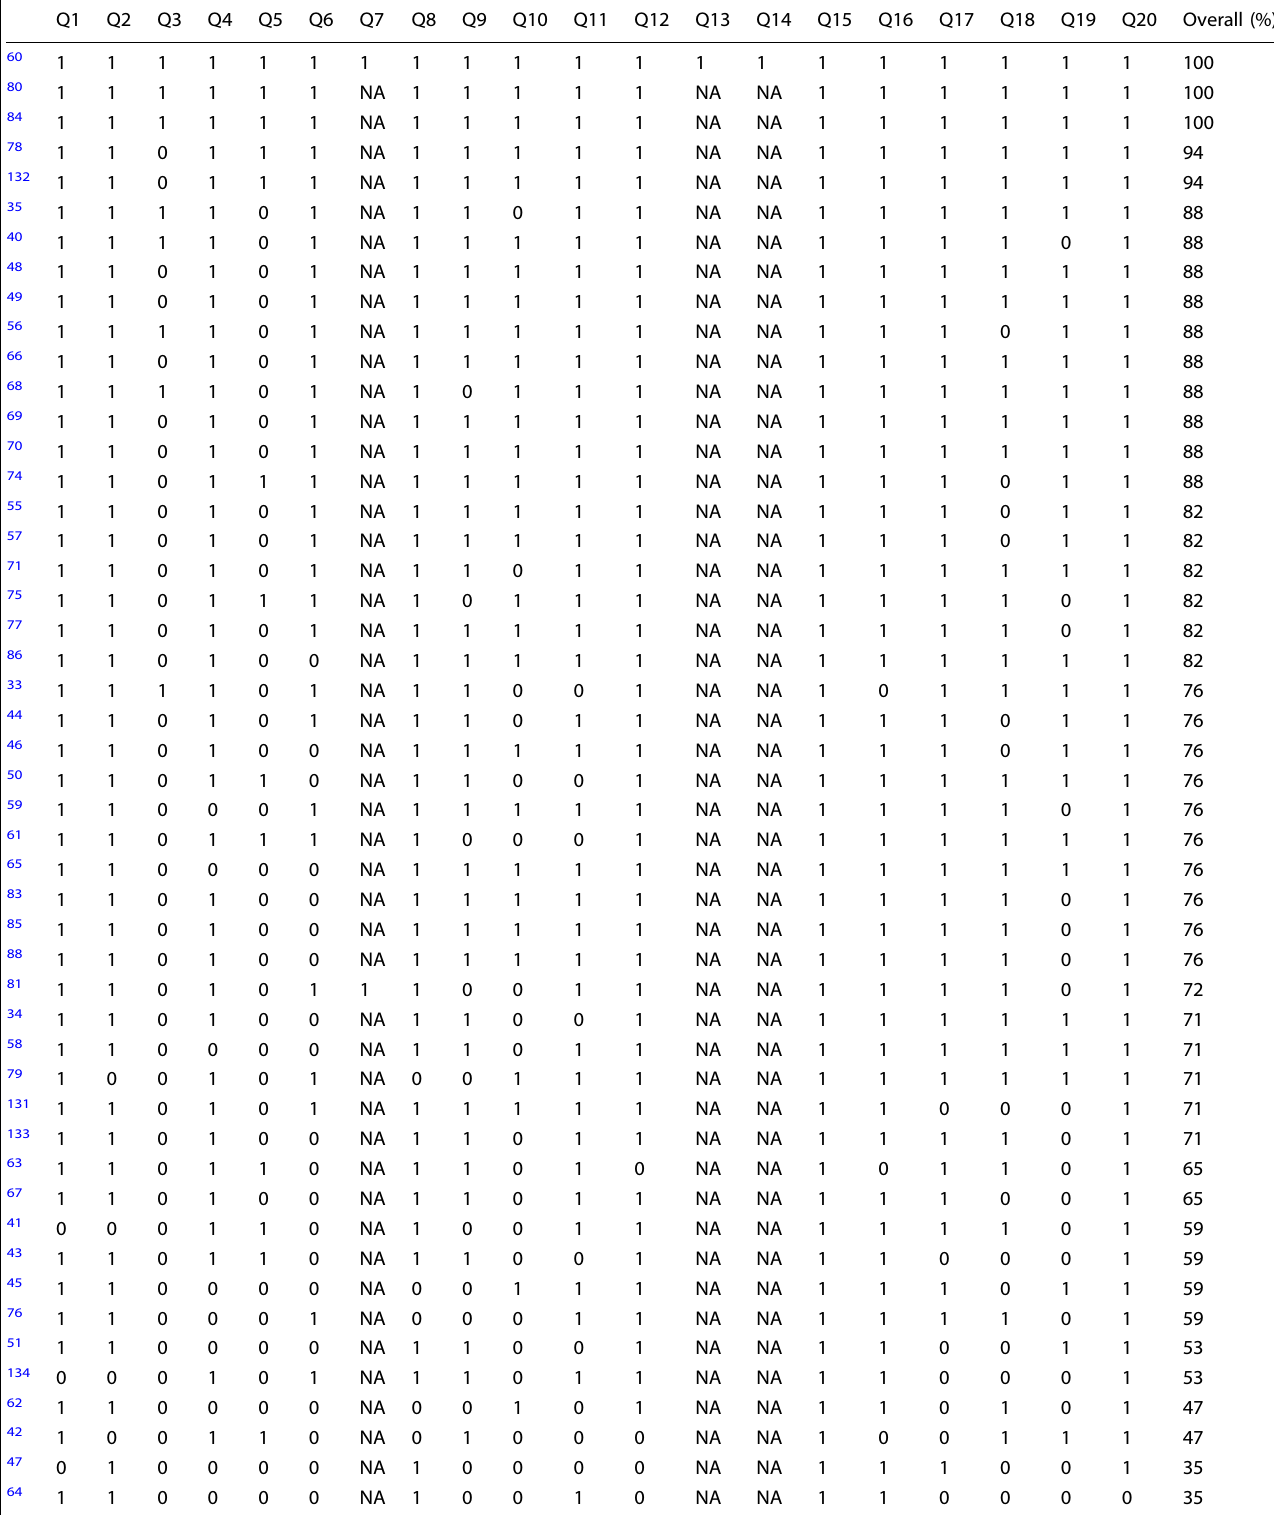
Table 3. AXIS quality assessment results of the included